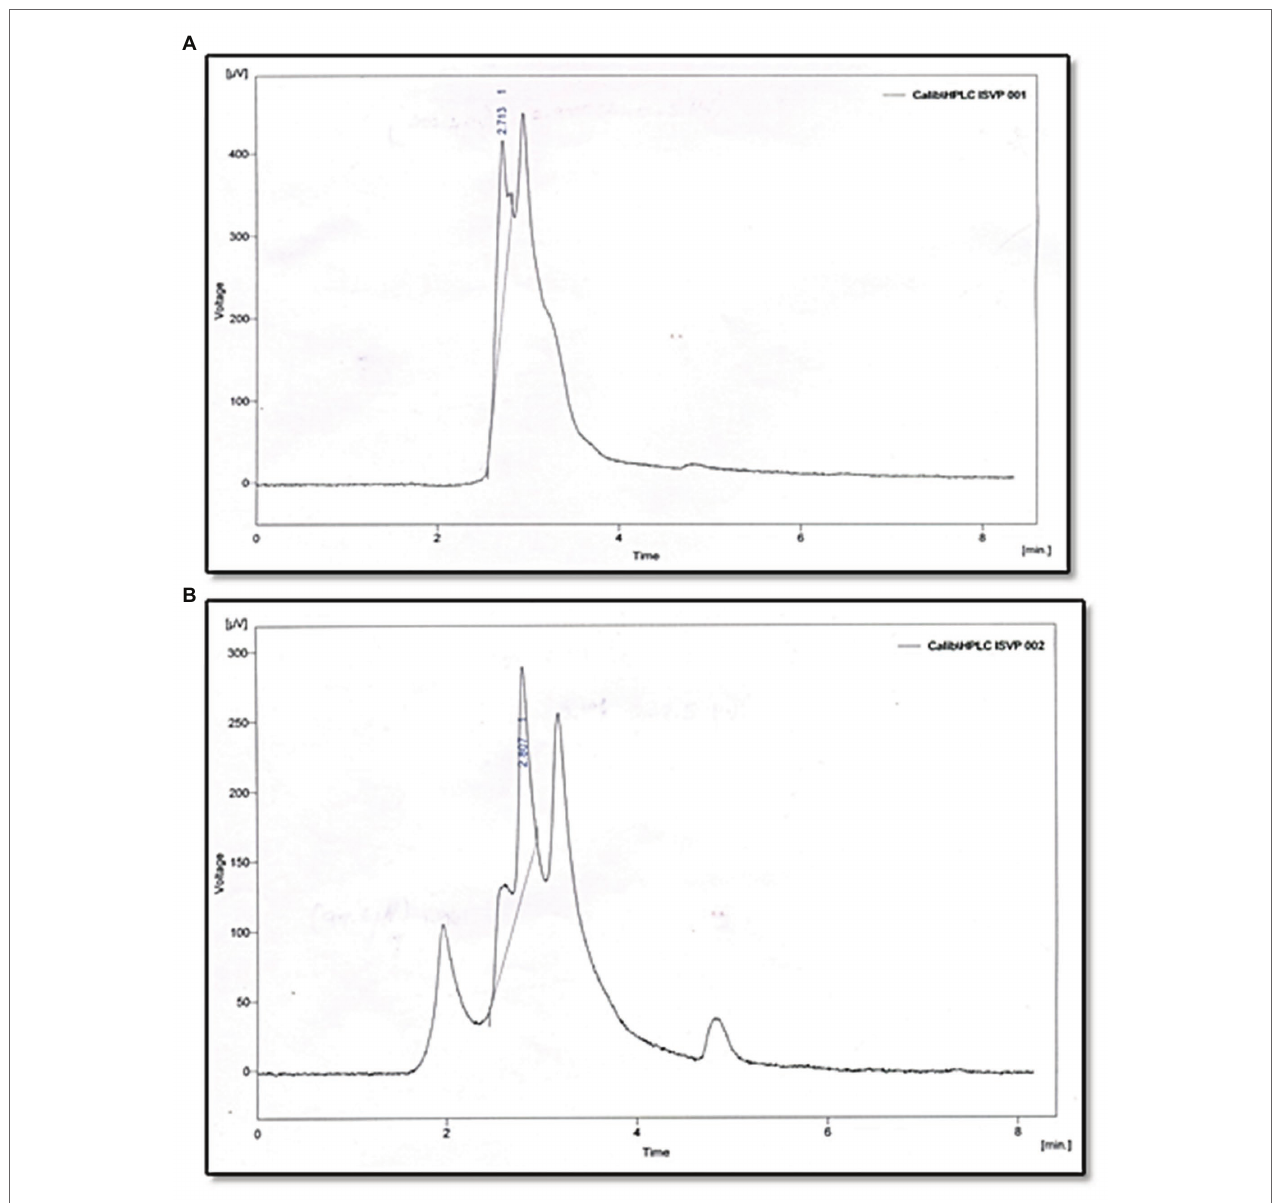
FIGURE 5 | Analysis of C 6 HSL degradation by Psychrobacter sp. through HPLC. (A) C 6 HSL alone. (B) C 6 HSL treated with Psychrobacter